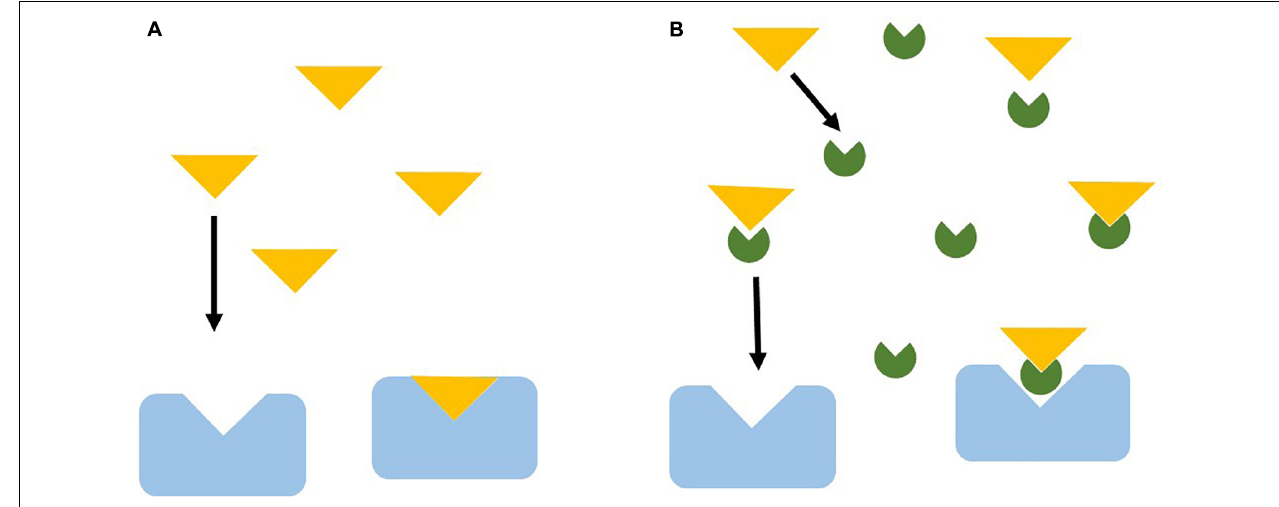
FIGURE 3 | Scheme showing how chemical communication can be impaired by DOC. Blue boxes = chemical receptors, Yellow triangles = pheromones, Green semi-circles = DOC. (A) Pheromones flow through the water column and reach chemical receptors, (B) DOC bind to pheromones, DOC + pheromones complex fail to attach to chemical receptors, not eliciting a behavioral